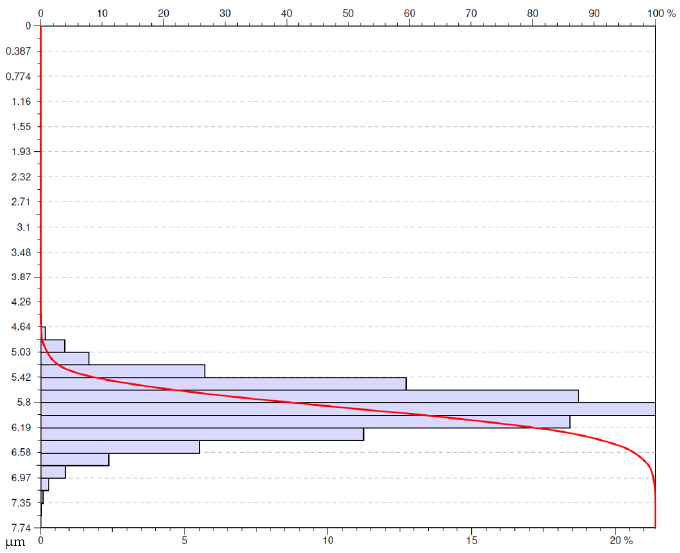
Figure 18. Abbott-Firestone curve after dry turning by special insert with feed f = 0.05 mm/rev.